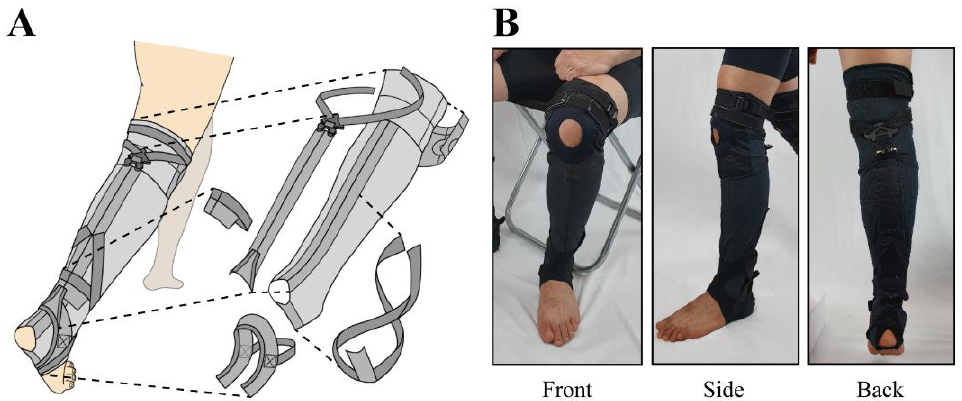
Figure 3. Overall composition of kneE-XOcks from the knee to the sole of the foot. ( A ) As each part is a separate piece of garment, the wearer can quickly and comfortably pull on kneE-XOcks as if they were wearing socks. ( B ) Consequently, kneE-XOcks can have a thinner and lighter design.